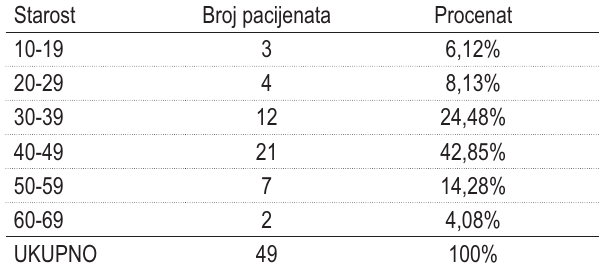
TABELA 2. Broj muških pacijenata ukljuwenih u istraživanje Starost